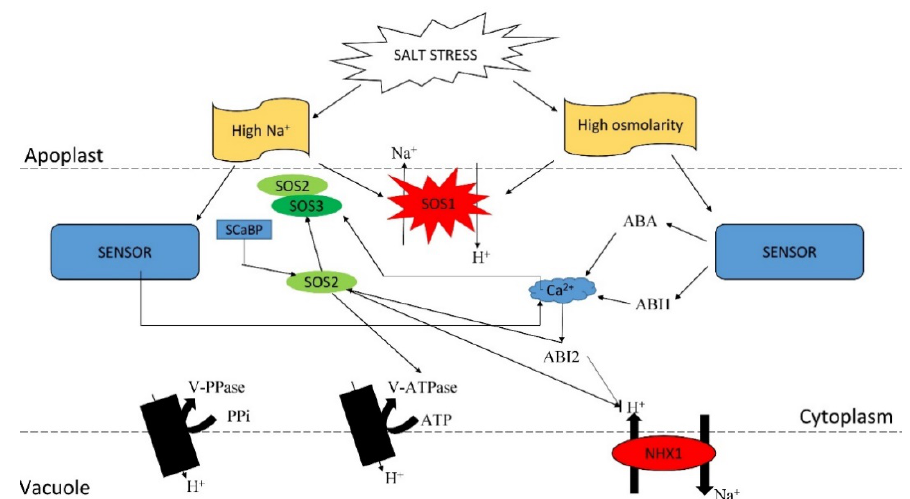
Figure 4. Signaling pathways responsible for Na+ extrusion in Arabidopsis under salt stress. Excess Na+ and high osmolarity are separately sensed by unknown sensors at the plasma membrane level, which then induce an increase in cytosolic Ca2+. This increase is sensed by SOS3, which activates SOS2. The activated SOS3-SOS2 protein complex phosphorylates SOS1, the plasma membrane Na+/H+ antiporter, resulting in the efflux of Na+ ions. SOS2 can regulate NHX1 antiport activity and V-H+-ATPase activity independently of SOS3, possibly by SOS3-like Ca2+-binding proteins (SCaBP) that target it to the tonoplast. Salt stress can also induce the accumulation of ABA, which, by means of ABI1 and ABI2, can negatively regulate SOS2 or SOS1 and NHX1.